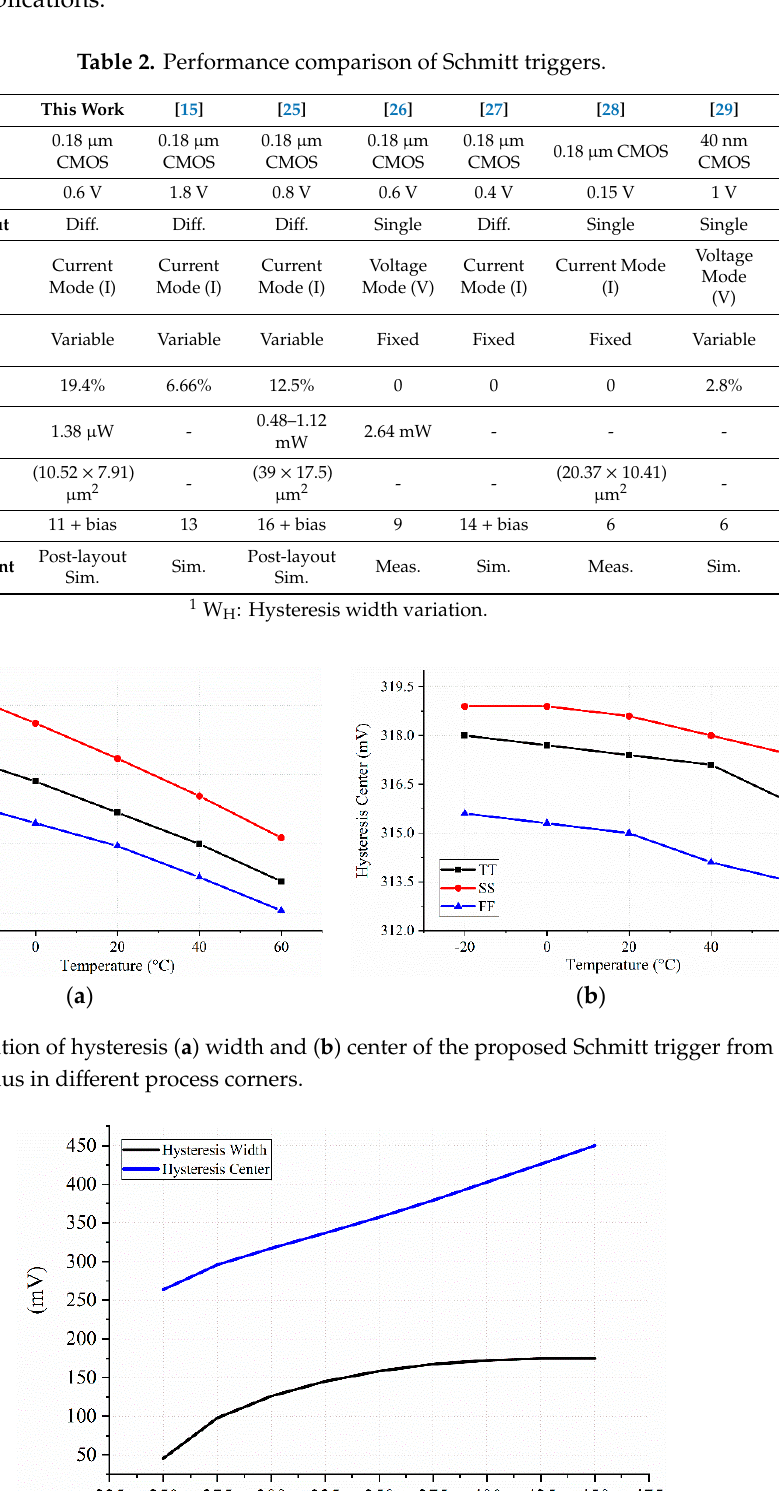
Figure 14. Dependence of the hysteresis width on the control voltage (V C1 ) and the reference voltage (V in − ). Figure 15. Post-layout simulation for 100 runs of Monte Carlo on the transient response of the input and output voltages.